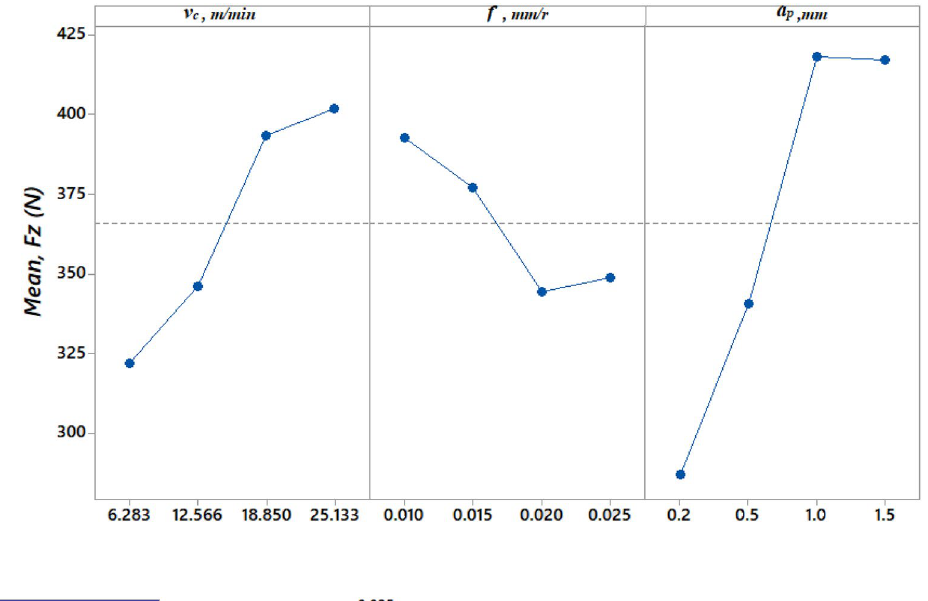
Fig. 11 main effect plot F z cut-